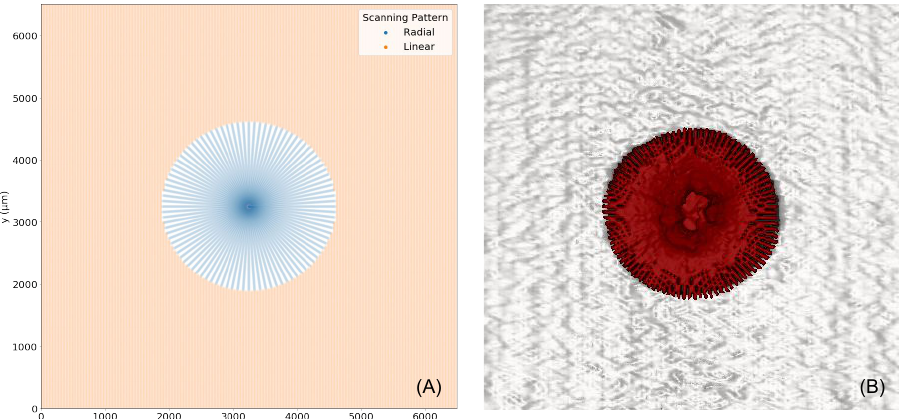
Figure 11. Radial and linear A-scans until a certain radius R. ( A ) represents the simulated fusion of both scanning patterns. ( B ) represents the real fusion of both scanning